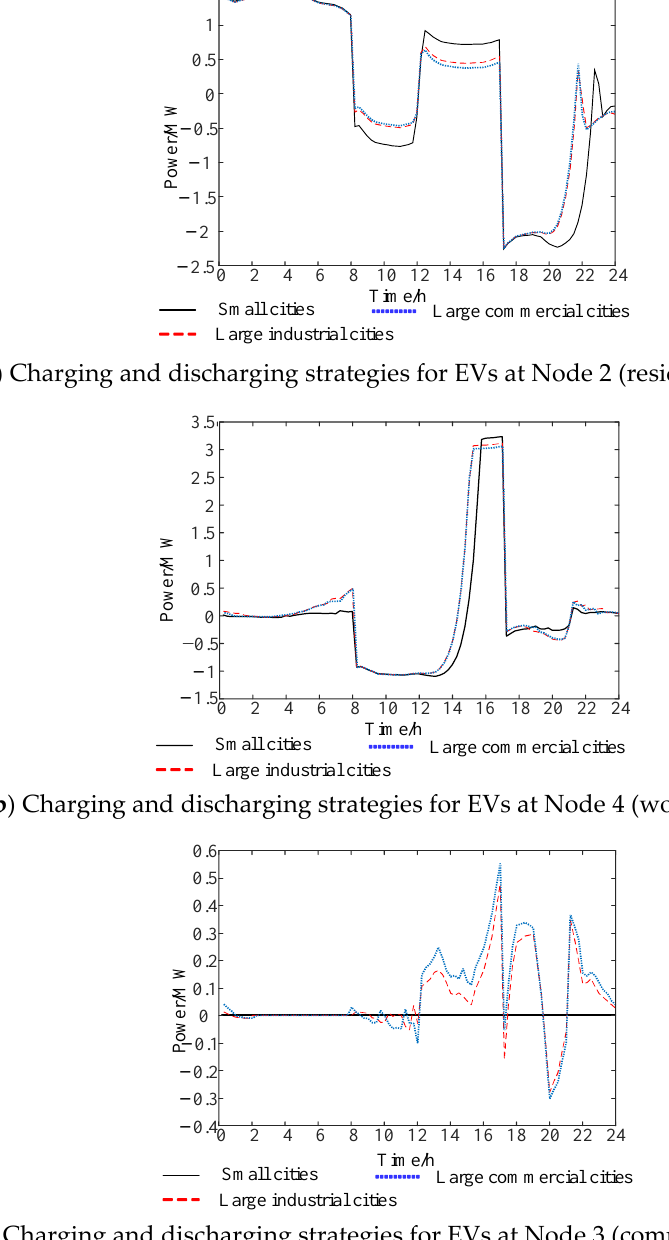
( c ) Charging and discharging strategies for EVs at Node 3 (commercial area). Figure 7. Charging and discharging strategies of electric vehicles in different functional areas. Nodes 2, 3 and 4 represent residential, working, and commercial areas, respectively, for which we obtained the charging and discharging strategy of EVs, as shown in Figure 7. The distribution pattern of EVs in each region was fully considered when coordinating charging and discharging strategies. Charging and discharging strategies for EVs in residential areas make full use of the peak-valley electricity use pattern by charging at night to “fill” the valley and discharging during the evening (17:00 ~ 21:00) to relieve the peak load. The EVs in the working area discharge during the peak load period and charge dur- ing the normal load period so that they are fully charged for their next trip. The charging and discharging power of EVs in commercial areas fluctuates greatly because the resi- dence time of EVs in commercial areas is shorter and more random.